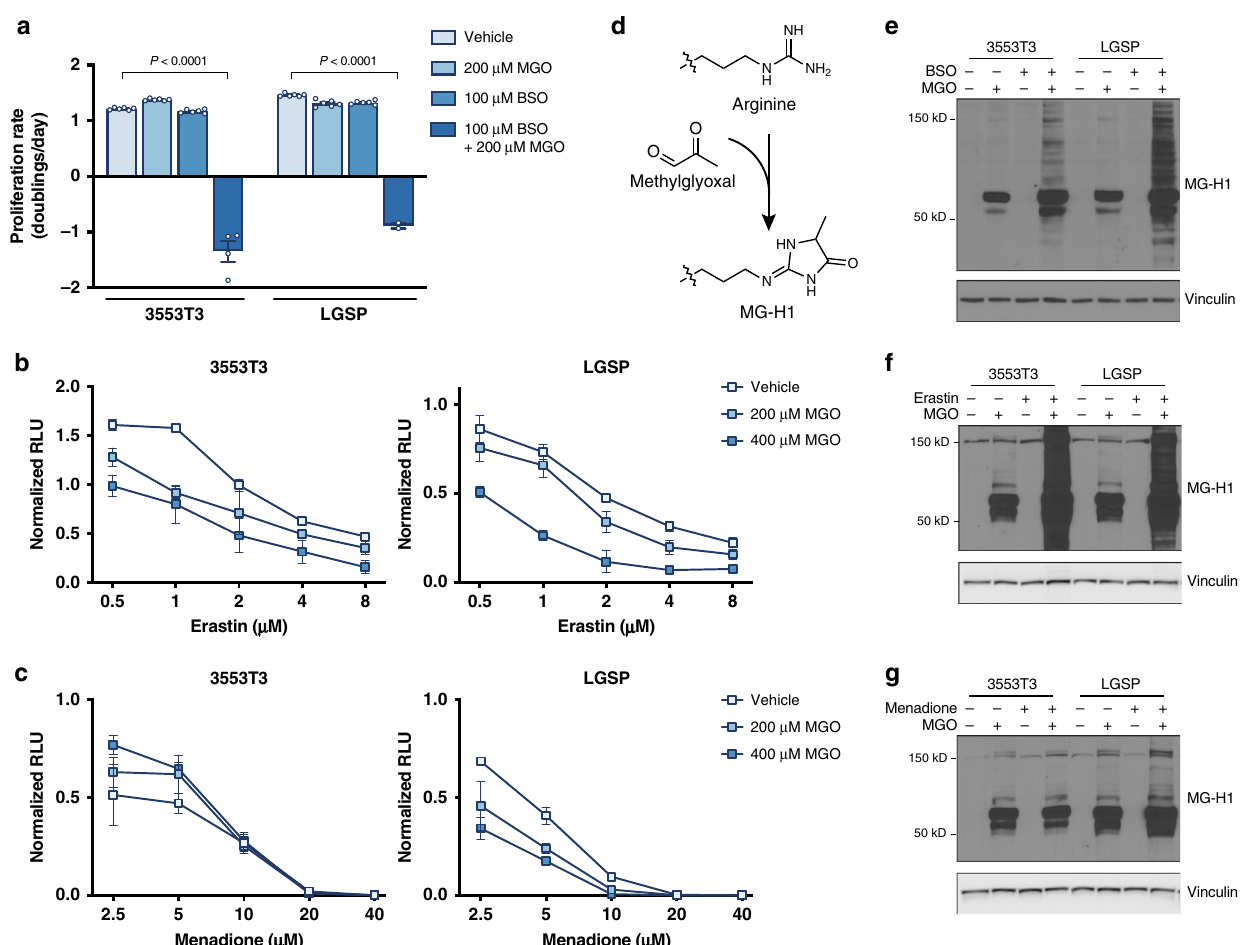
Fig. 3 Glutathione depletion sensitizes NSCLC cell lines to methylglyoxal. a Proliferation rate of 3553T3 and LGSP cells cultured in standard media or in media containing the indicated amount of methylglyoxal (MGO) or buthionine sulfoximine (BSO), an inhibitor of glutathione synthesis. Cells treated with BSO had been pre-treated with BSO for 48 h prior to the initiation of the experiment. The P values were calculated by unpaired, two-tailed t -test ( n = 6). b , c Effect of the indicated concentration of erastin, which depletes intracellular glutathione by inhibition of system x c − ( b ), and menadione, which induces formation of reactive oxygen species ( c ), on cell viability as assessed using the CellTiter-Glo Luminescence Assay in 3553T3 and LGSP cells cultured in standard media or in media containing the indicated doses of methylglyoxal ( n = 3). d Schematic detailing how methylglyoxal can react non-enzymatically with arginine to form the hydroimidazolone MG-H1. e Western blot analysis of lysates from 3553T3 and LGSP cells that had been incubated with 200 μ M of methylglyoxal, 100 μ M of BSO, or both for 24h using an antibody raised against the MG-H1 epitope. Cells treated with BSO had been pre-treated with BSO for 48 h prior to the initiation of the experiment. f , g Western blot analysis of lysates from 3553T3 and LGSP cells to assess accumulation of proteins containing MG-H1 epitopes following 24 h of culture in standard media or in media containing 200 μ M methylglyoxal, 10 or 5 μ M erastin (3553T3, LGSP respectively), or both as indicated ( f ), or 200 μ M methylglyoxal, 2 or 1 μ M menadione (3553T3, LGSP respectively), or both as indicated ( g ). Values in panels a – c denote mean ±